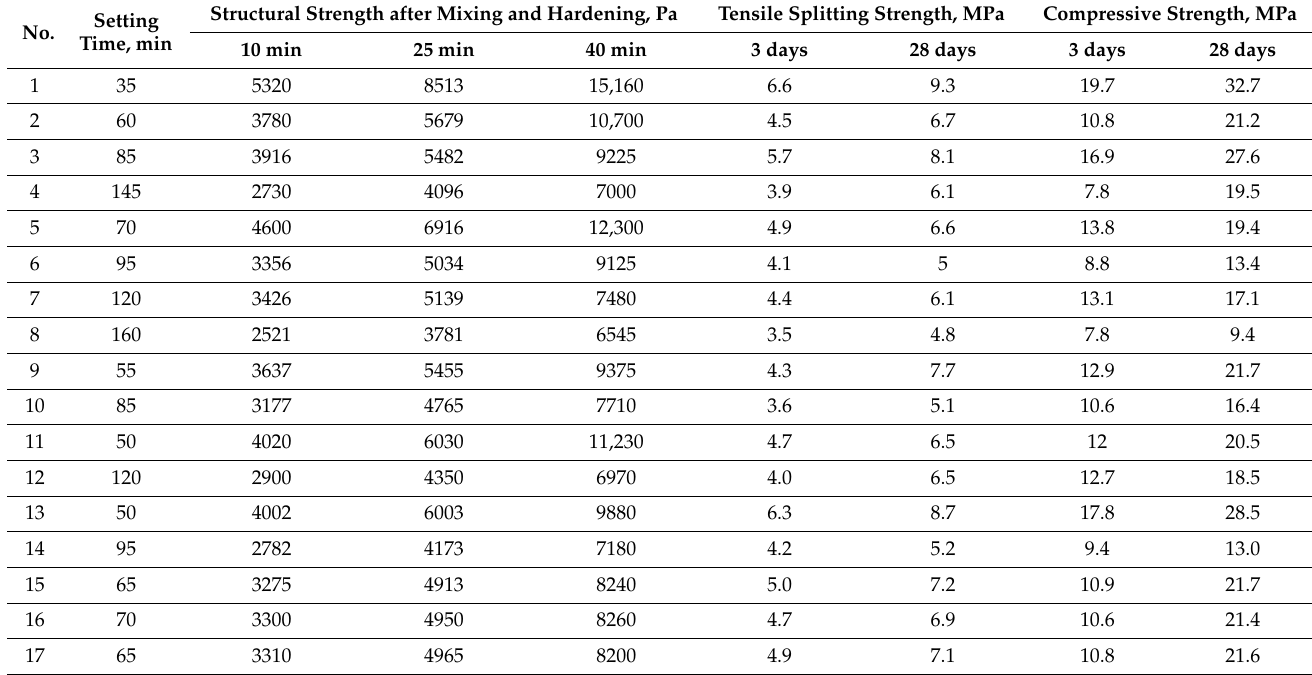
Table 4. Experimental research results.